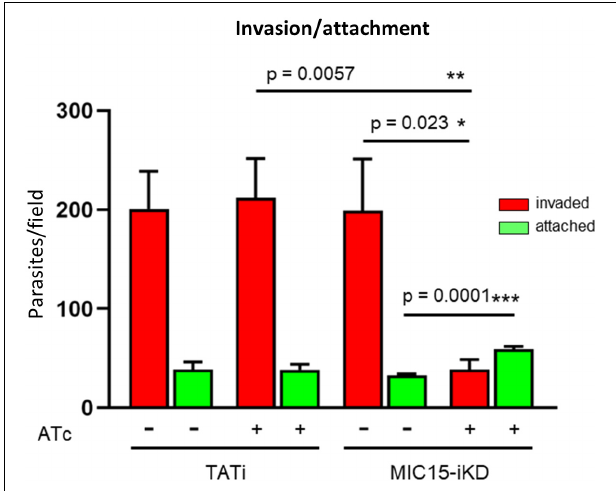
FIGURE 6 | MIC15 depletion impacts on host cell invasion. Invasion assay showing a marked reduction of the number of invaded tachyzoites (red bars) following Atc-induced depletion of MIC15. The green bars represent the number of attached parasites enumerated for each strain and condition. Values represent means ± SEM from 4 independent experiments performed in triplicate. Statistical significance was determined by the Student’s two tailed t -test. * p < 0.05, ** p < 0.01, *** p <